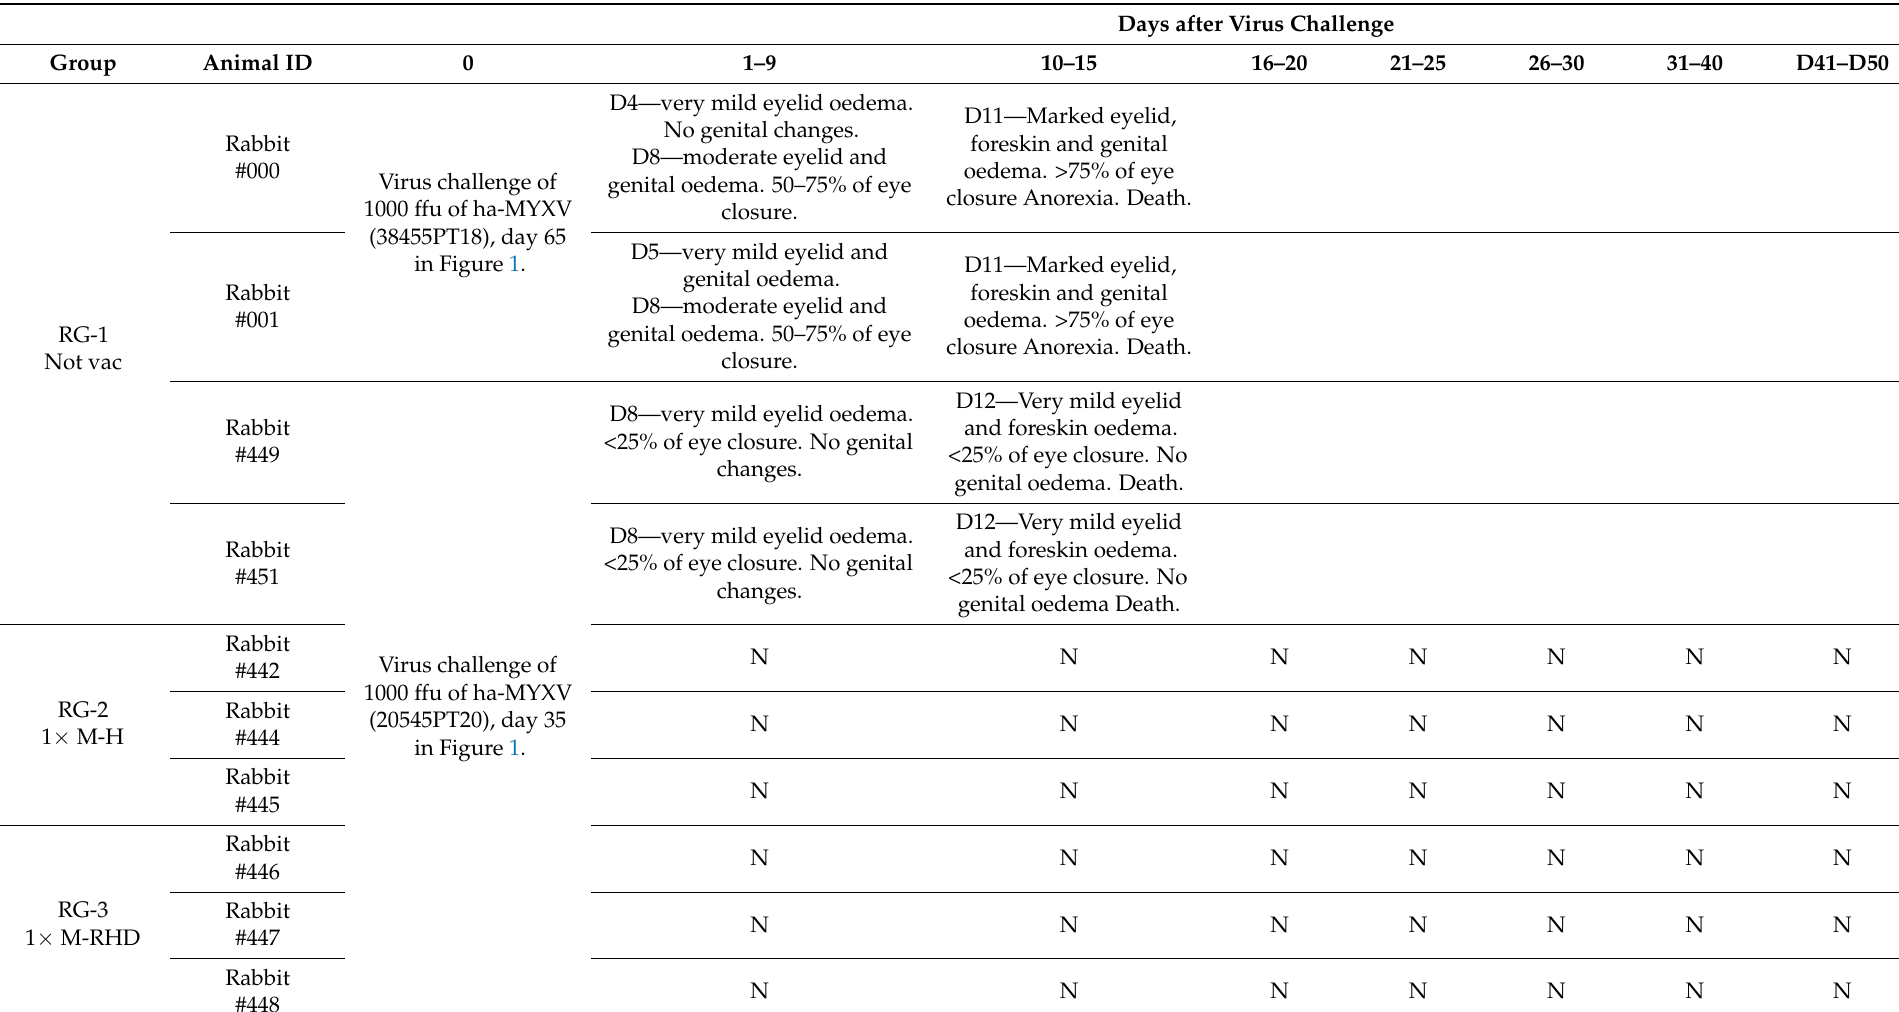
Table 4. Clinical data of wild rabbits after challenge with ha-MYXV isolated from wild rabbit (20545PT20) or Iberian hare